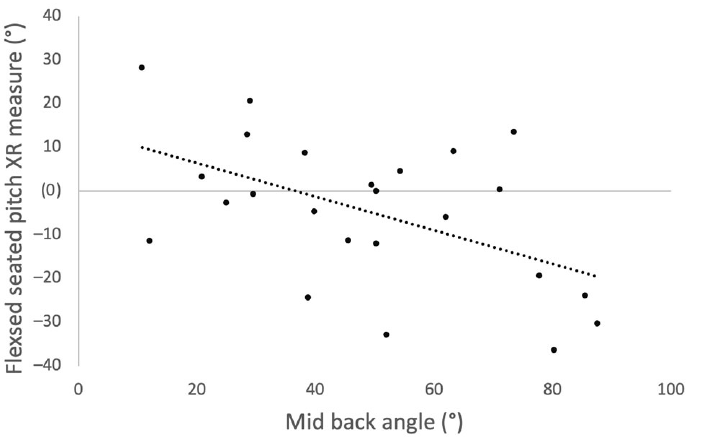
Figure 5. Scatter plot showing correlation between mid-back angle and change in pitch measured by XR when the participants moved into the flexed seated position from standing.